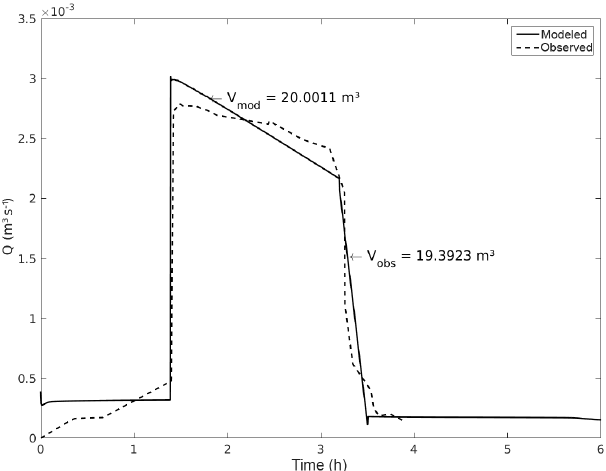
Figure 9. Injection rate of the experiment. The dashed line shows the observed injection in the field experiment (total volume of in- jected water 19.4m 3 ) and the solid line shows the calibrated injec- tion rate of the flow and transport